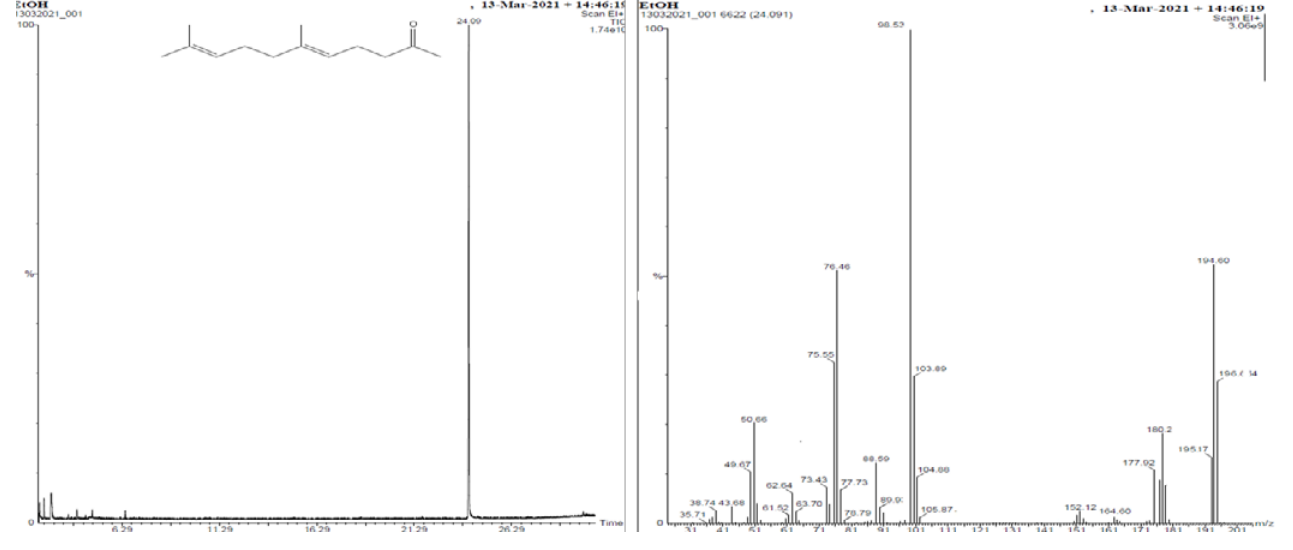
Figure 3. GC-MS analysis of geranylacetone.